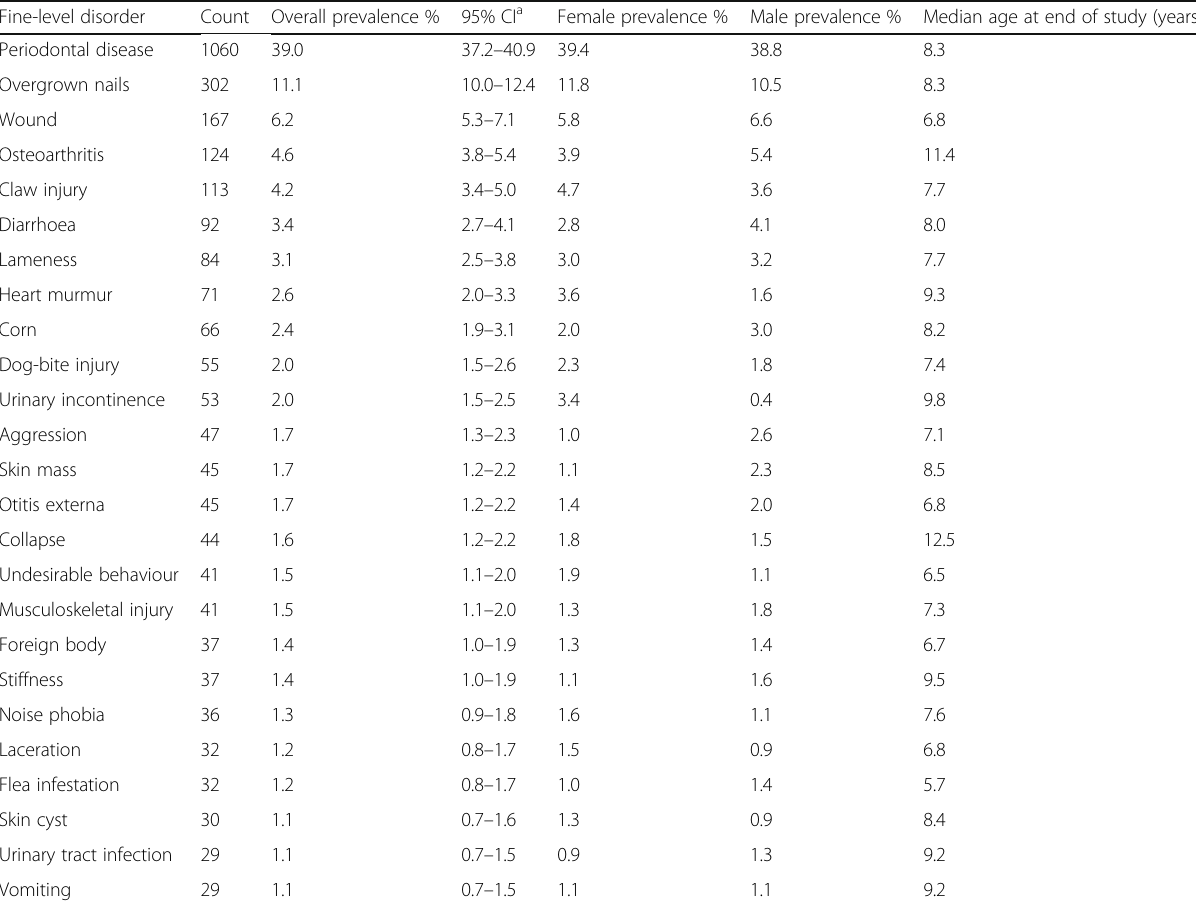
Table 3 Prevalence of the most common disorders at a fine-level of diagnostic precision recorded in greyhounds ( n = 2715) attending UK primary-care veterinary practices participating in the VetCompass ™ Programme from January 1st to December